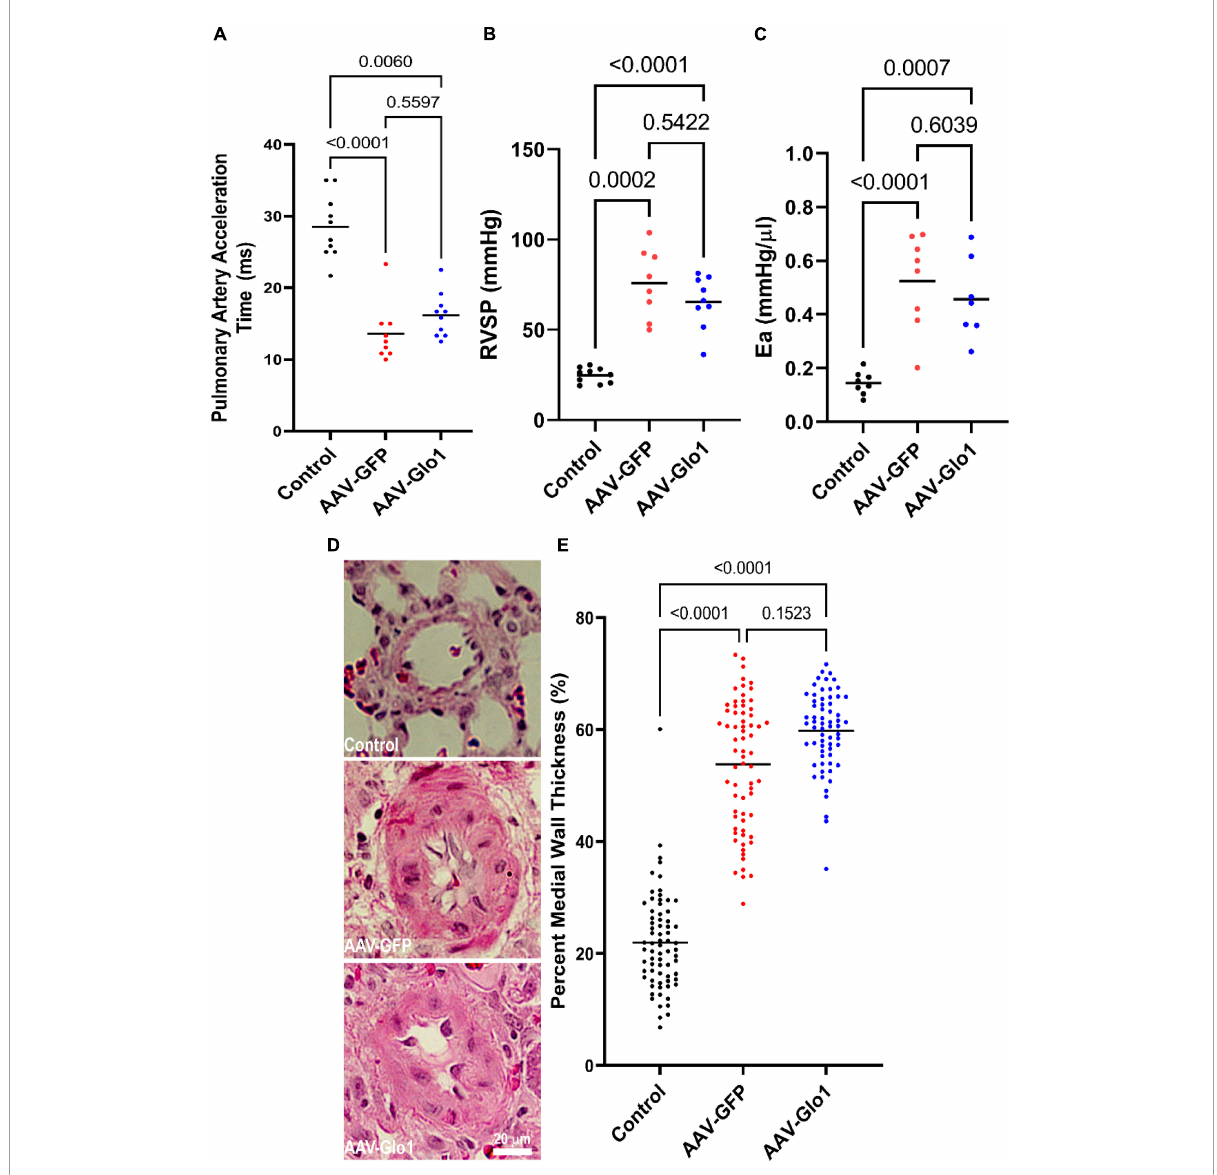
FIGURE7 GLO1 overexpression did not alter PAH severity. Pulmonary artery acceleration time (A) , RV systolic pressure (RVSP) (B) , and effective arterial elastance (Ea) (C) were all equivalent in AAV-GFP and AAV-Glo1 rats. (D) Representative images of hematoxylin and eosin stained small pulmonary arterioles. Scale bar 20 µ m. (E) Quantification of small arteriole remodeling in lung sections. p -values determined by Kruskal-Wallis test with Dunn’s multiple comparison test in (A,E) , Brown-Forsythe and Welch ANOVA with Dunnett multiple comparisons test in (B) , and one-way ANOVA with Tukey’s multiple comparisons test in (C)